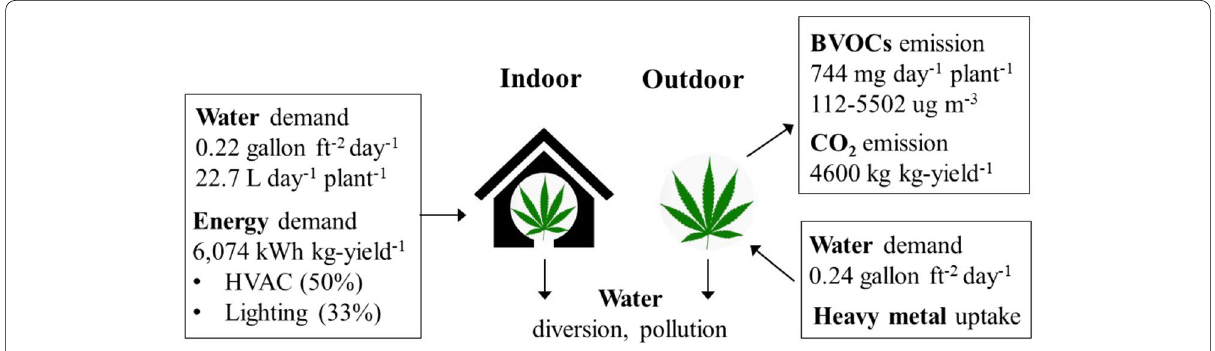
Fig. 2 Summary of cannabis environmental